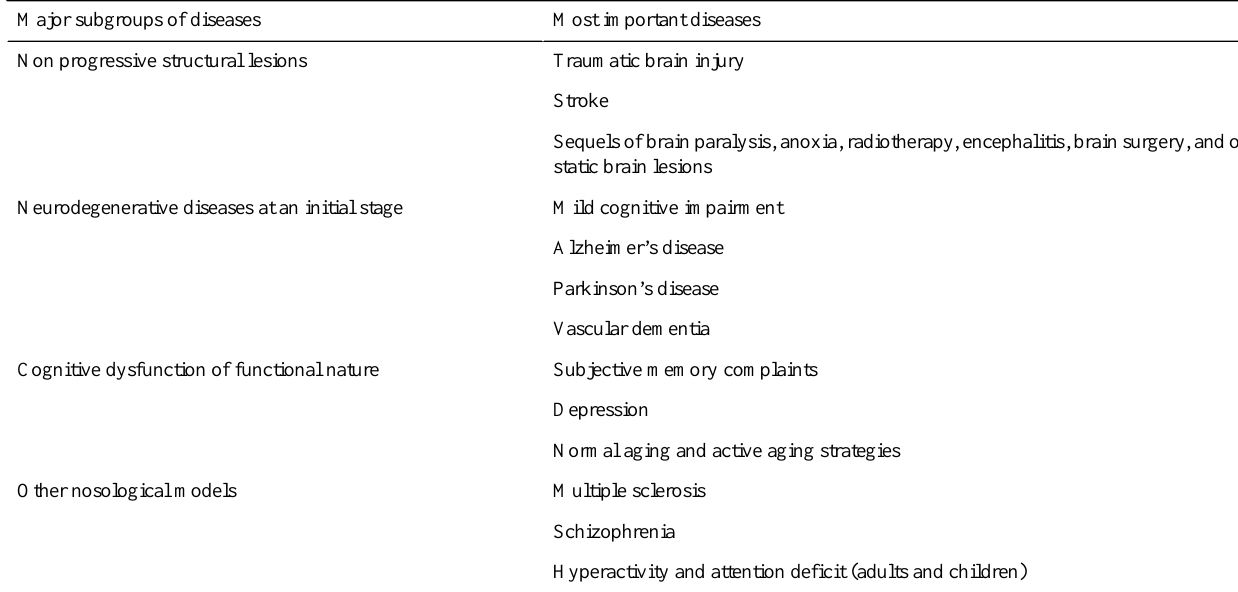
Table 1. Target neurological conditions of the COGWEB system.